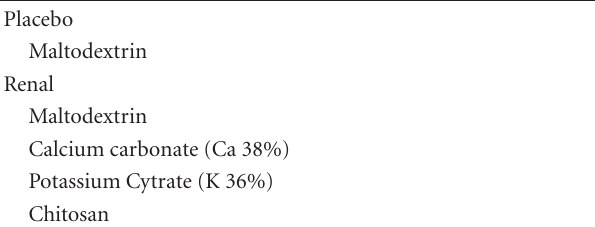
Table 1: Composition of placebo and Renal.